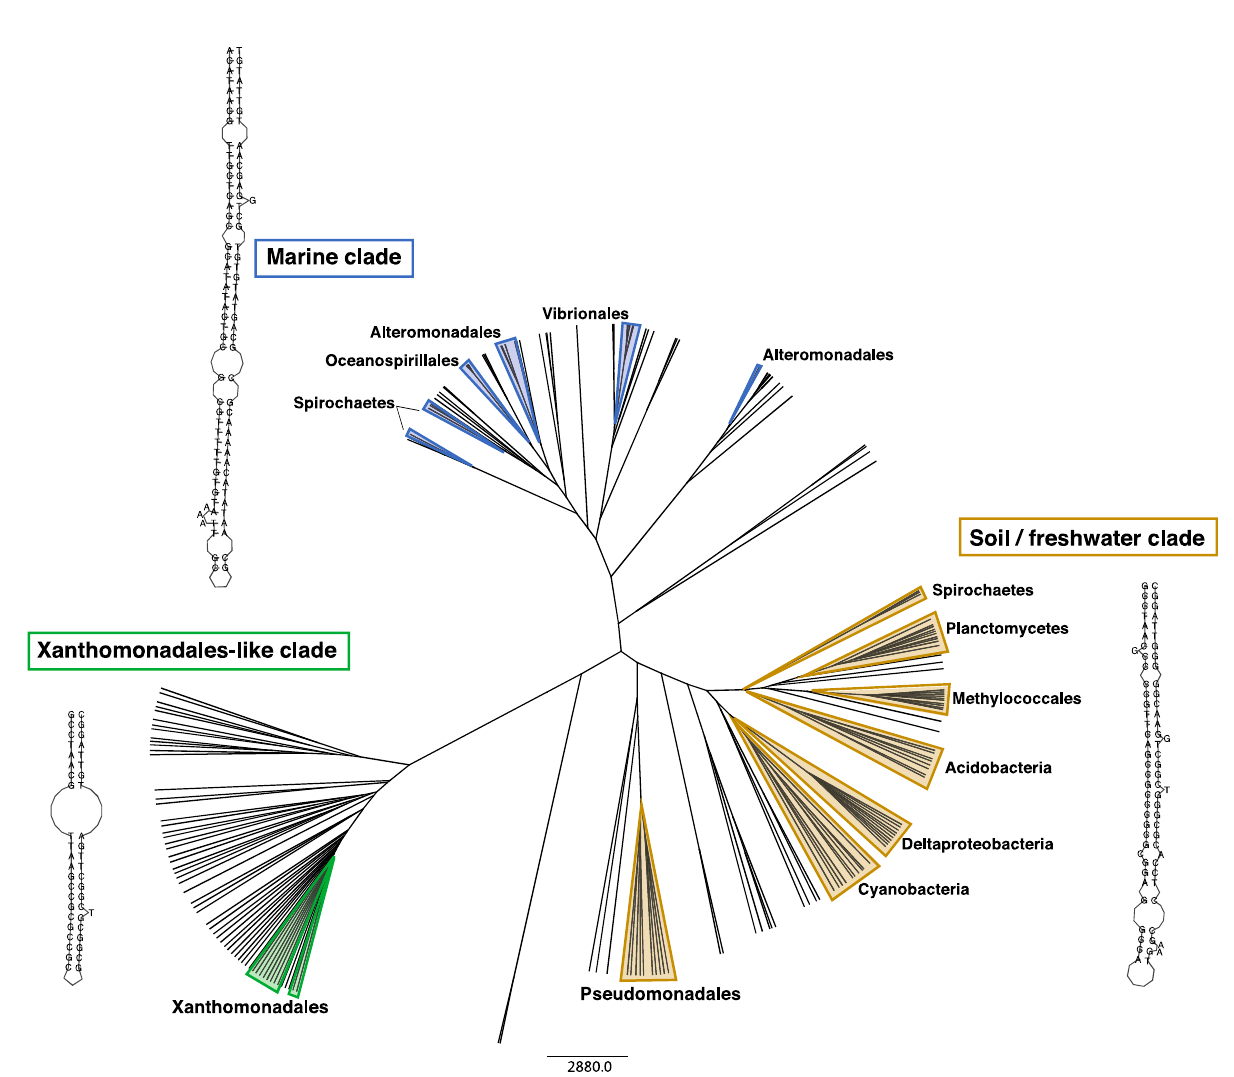
Figure 2. Environmental clustering of attC sequence and folding structures. The tips of the tree each represents an attC site. Tips outlined by shaded triangles represent attC s from chromosomal integrons. Unshaded tips represent attC s of antimicrobial resistance gene cassettes carried by class 1 integrons. Based on their sequence and structure, attC s cluster according to their environment, rather than host phylogeny, forming three major clades. Note that the sequence and structural diversity of attC s from class 1 integron gene cassettes spans that of all chromosomal attC s. The folded bottom strand of the best-fitting representative attC s from each clade are shown. These were determined by generating covariance models (CMs) built on the attC s from each clade, using previously described methods [10]. The attC s that best fit each model (based on CM bit scores) were selected as representatives and their structure predicted using RNAfold v2.4.16 from the ViennaRNA Package 2.0 [26] .